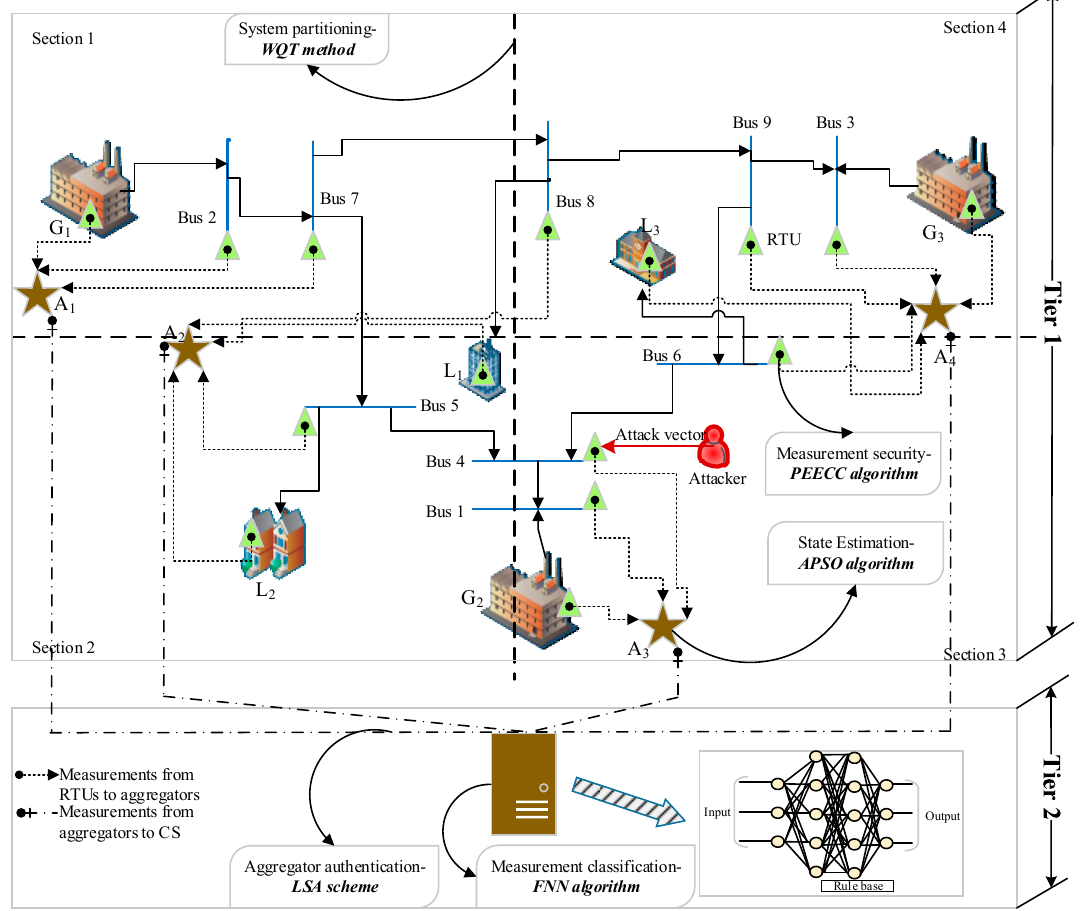
Figure 2. Two-tier secure smart grid (T 2 S 2 G) system architecture based on the IEEE-9 bus